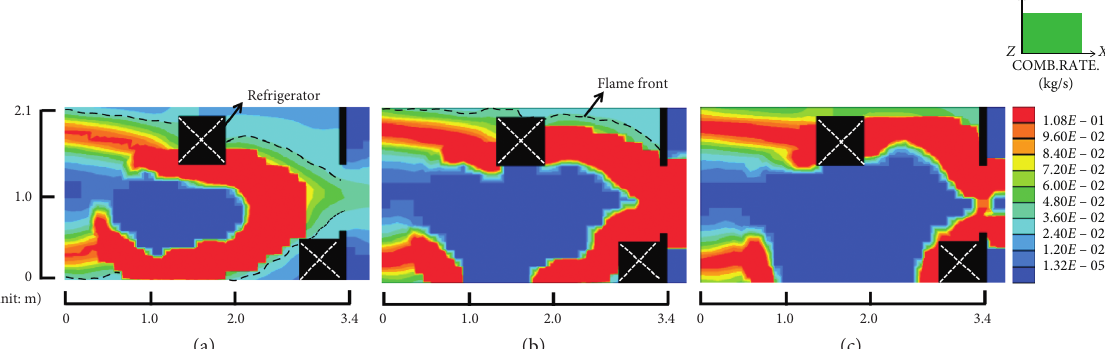
Figure 8: The expansion of explosion flame area at the moments of Figures 7(a)-7(c) on the z � 1.4m slice (the black-dotted line is the flame front). (a) 295ms. (b) 316 ms. (c)